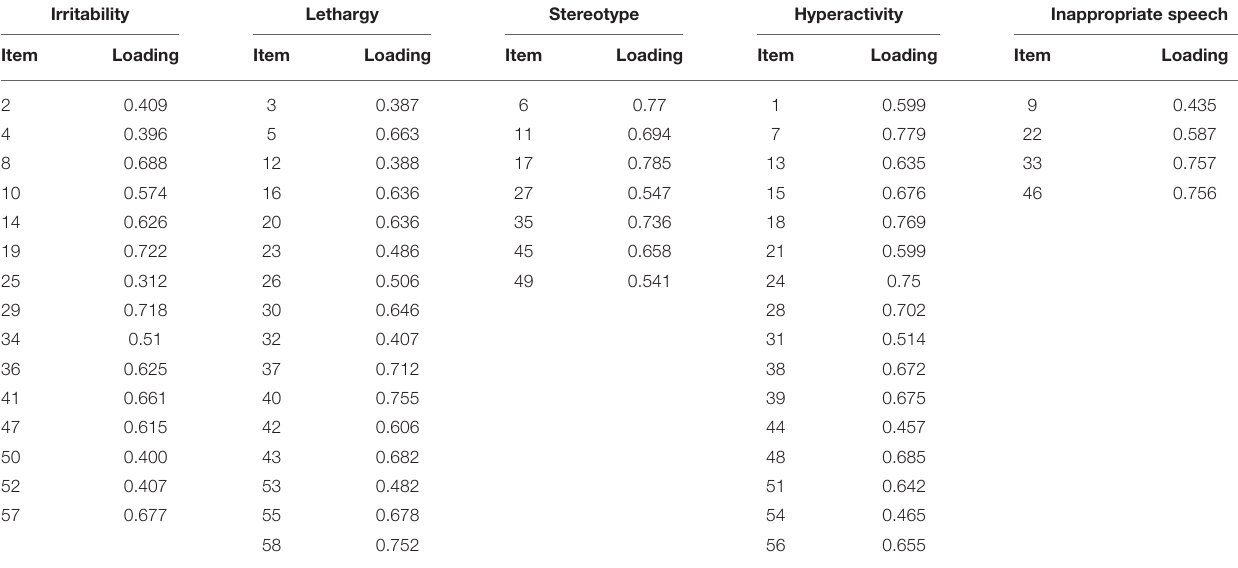
TABLE 7 | Standard factor loading of the